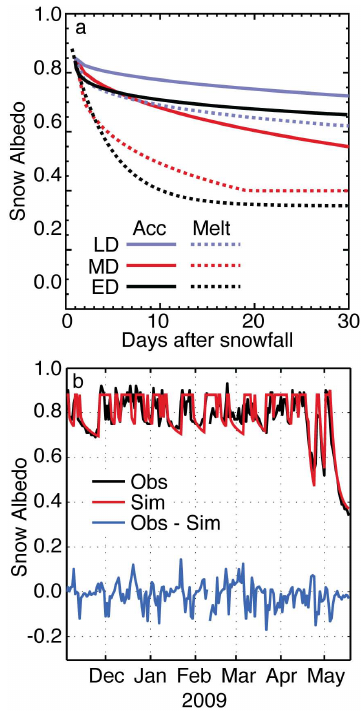
Fig. 2. (a) Snow albedo decay curves for moderate dust (MD), low dust (LD), and extreme dust (ED) deposition scenarios. (b) Time series of observed 2009 albedos at Swamp Angel Study Plot in Sen- ator Beck Basin, CO, simulated ED snow albedos, and